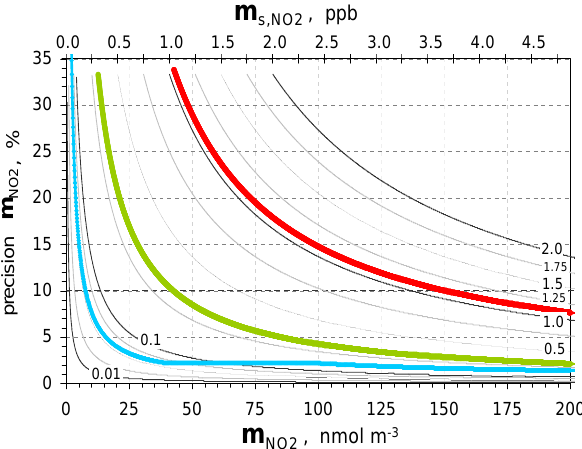
/m NO ) of the applied NO/NO 2 ana- 2 2 ) ≤ 2ppb are also shown (numbers 2